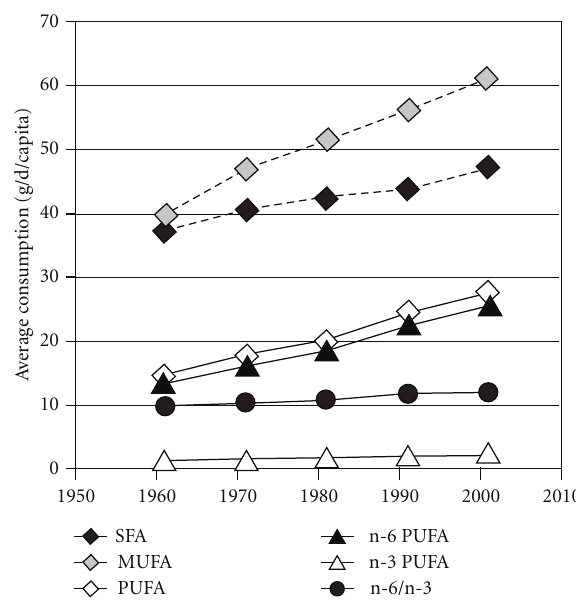
Figure 2: Evolution of fatty acids consumption in European Union. Adapted from